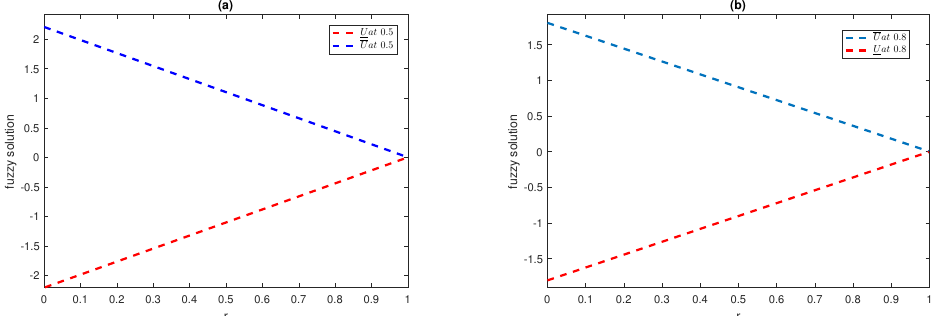
Figure 1. 3-D fuzzy upper and lower branch plot of semi-analytical series solution up to first four terms at τ = t = 0.5, x 2 = y = 0.5, and at θ = 0.5, 0.8, for Example 1.